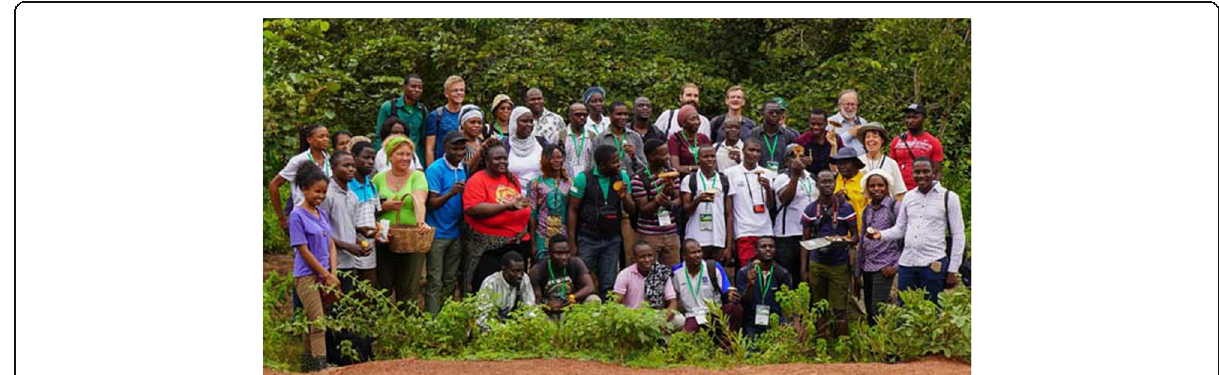
Fig. 14 Group picture during the excursion at Okpara forest. Photo: André De